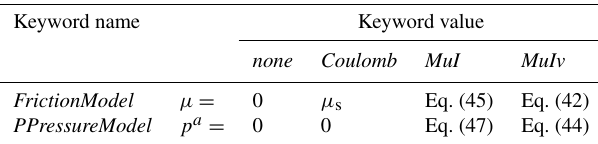
Table 7. List of the dense granular-flow rheology models that can be selected through the keyword FrictionModel and PPressureModel together with model equation